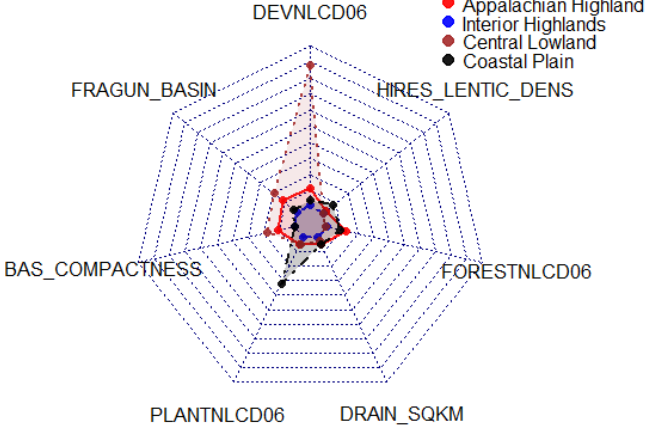
Figure 12. Comparison of importance levels for watershed variables (ranking 1 to 10) common to more than one region.